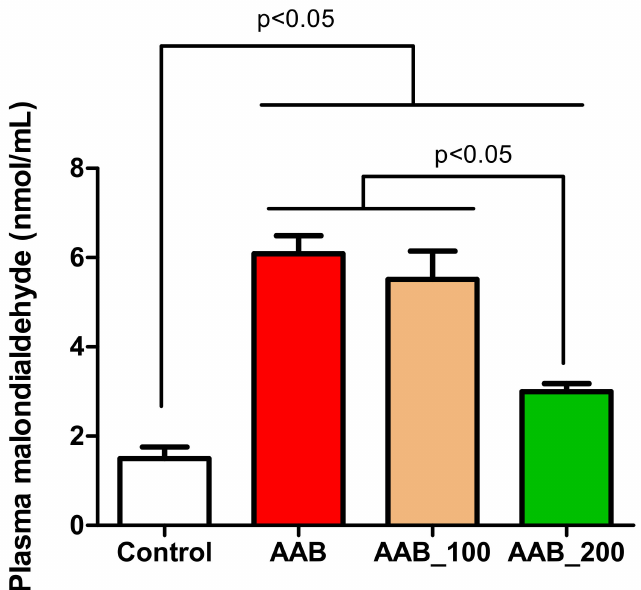
Figure 4. E ff ects of LBPs on plasma malondialdehyde levels at week